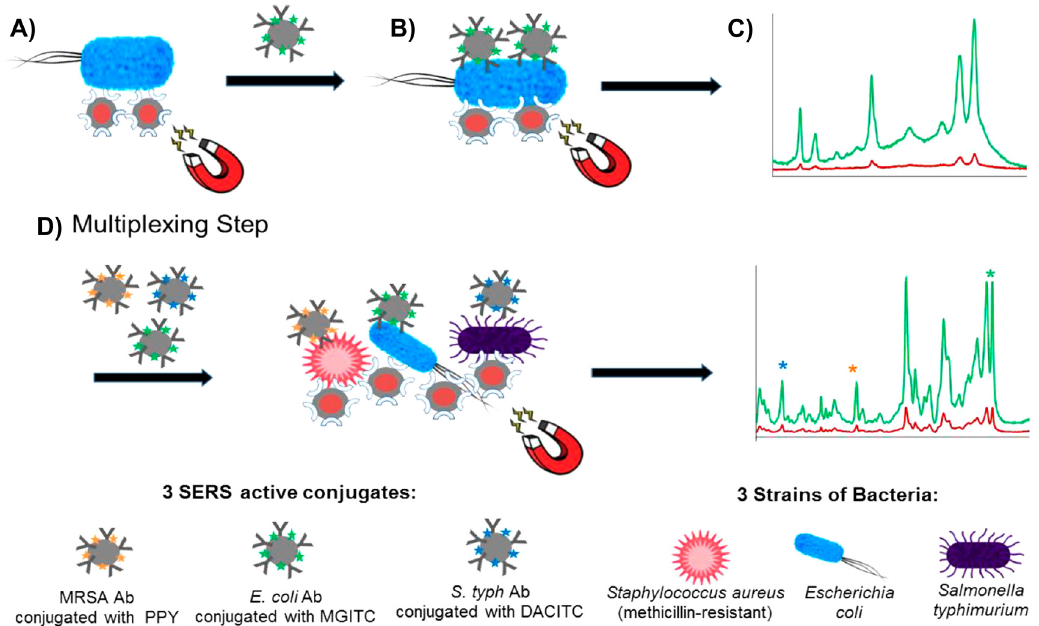
Figure 18: Schematic illustrating the single-plex and multiplex detection